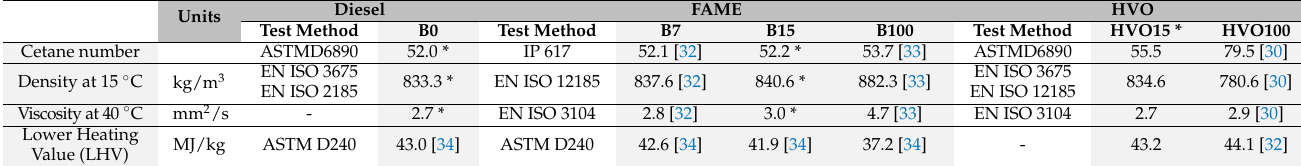
Table 3. The properties of the fuels used to carry out the tests (adapted from [30,32–34]).